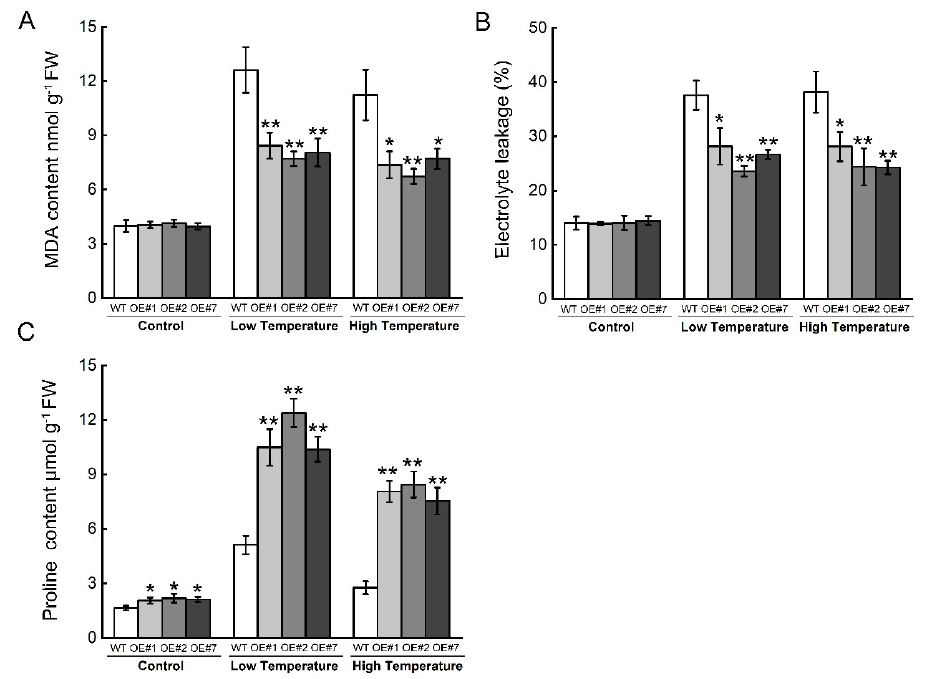
Figure 8. Oxidative damage and proline content in WT and OE lines of Arabidopsis plants. ( A ) Malondialdehyde (MDA) content in Arabidopsis seedlings. ( B ) Electrolyte leakage in Arabidopsis seedlings. ( C ) Proline content in Arabidopsis seedlings. Values represent mean ± SE ( n = 3). ** and * indicate significant differences in wild-type plants at the level of p < 0.01 and p < 0.05 respectively, using Student’s t-test.